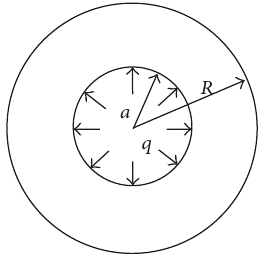
Figure 1: Cavity expansion source induced by the uniform pressure on the internal spherical surface.